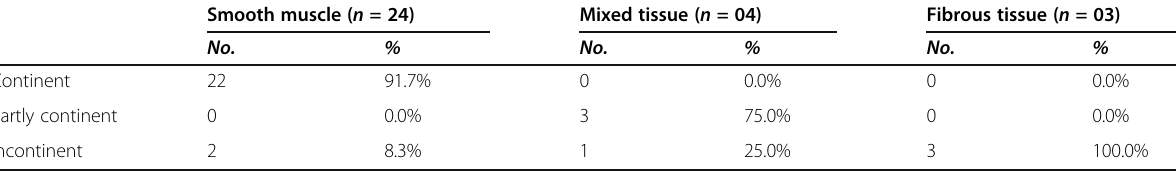
Table 2 Continence status in patients with different histopathological findings Smooth muscle ( n = 24) Mixed tissue ( n =